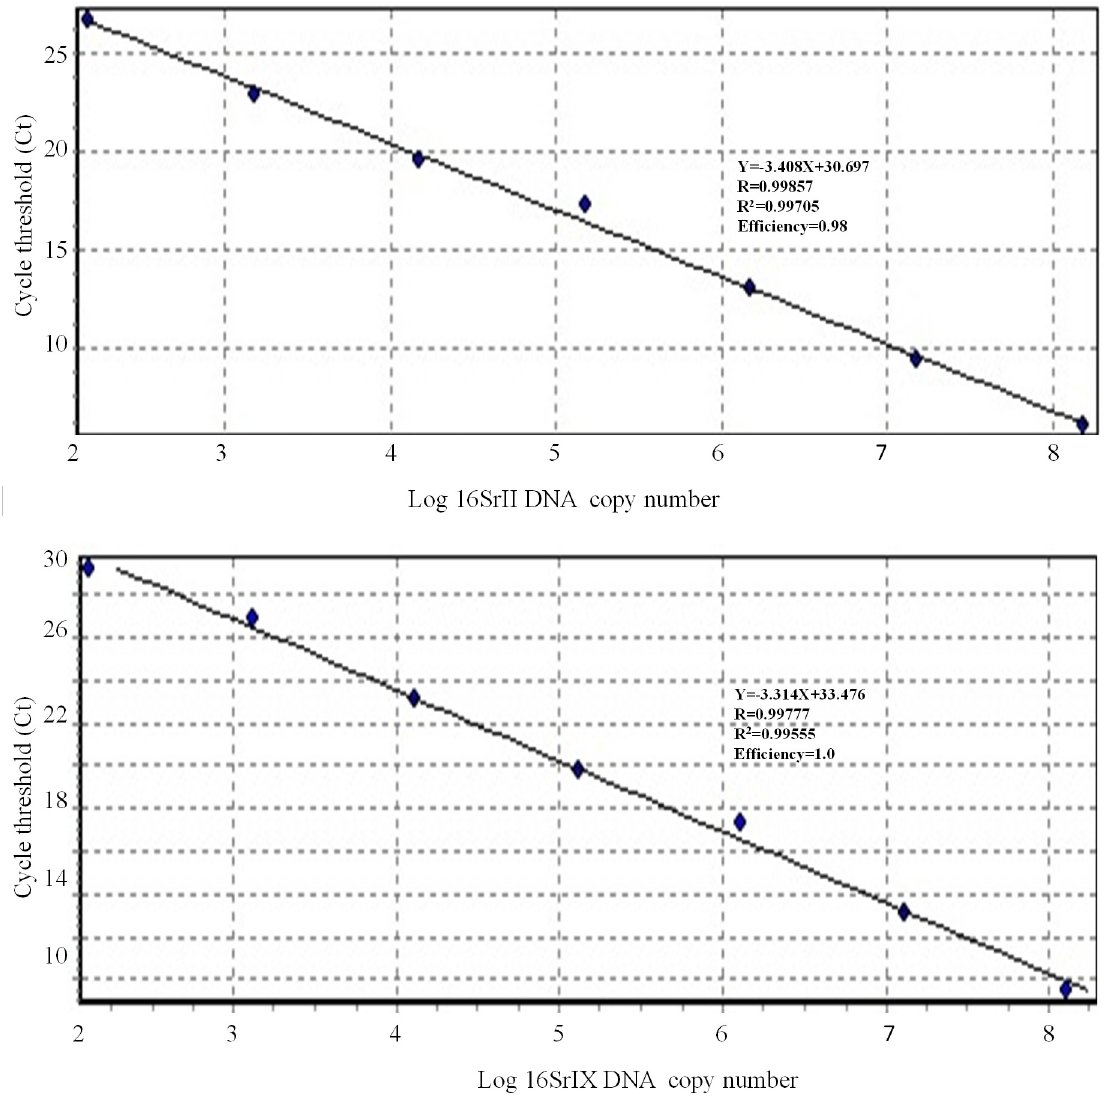
Fig 3. Standard curves generated from the multiplex qPCR amplification of seven 10-fold dilution series of 16SrII (A) and 16SrIX (B) group standards used to convert Ct values to the phytoplasma DNA copies present in the samples. The amplification mixture contained phytoplasma and sesame primers, as well as 16SrII, 16SrIX, and sesame probes. Each dilution series was added to 10 ng of uninfected sesame DNA per reaction as part of the inhibition experiments. Log 10 values of the initial copies of phytoplasma DNA are plotted against corresponding Ct